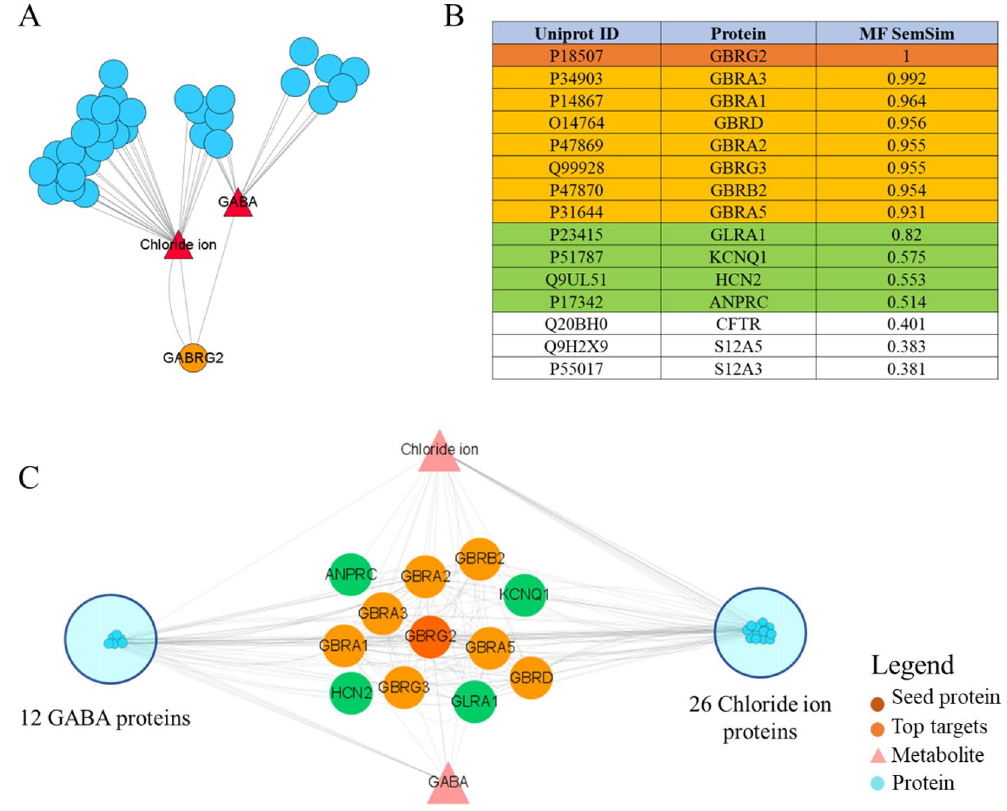
Figure 8. Integrated GBRG2-expanded multilayer biomolecular interaction network for candidate extraction and semantic similarity ranking of the proteins involved. ( A ) The complete network constructed using the major protein GBRG2 (orange nodes), linked to its direct metabolites (red nodes) which are linked to the proteins they interact with (blue nodes). We also show the metabolite-protein interactions (grey edges). ( B ) Semantic similarity ranking of proteins based on molecular function (MF SemSim) is highlighted, with the first 15 similar proteins. ( C ) The simplified network has only the main protein, with the top 12 similar proteins and metabolites shown separately, while the remaining proteins are grouped into modules and their interactions are